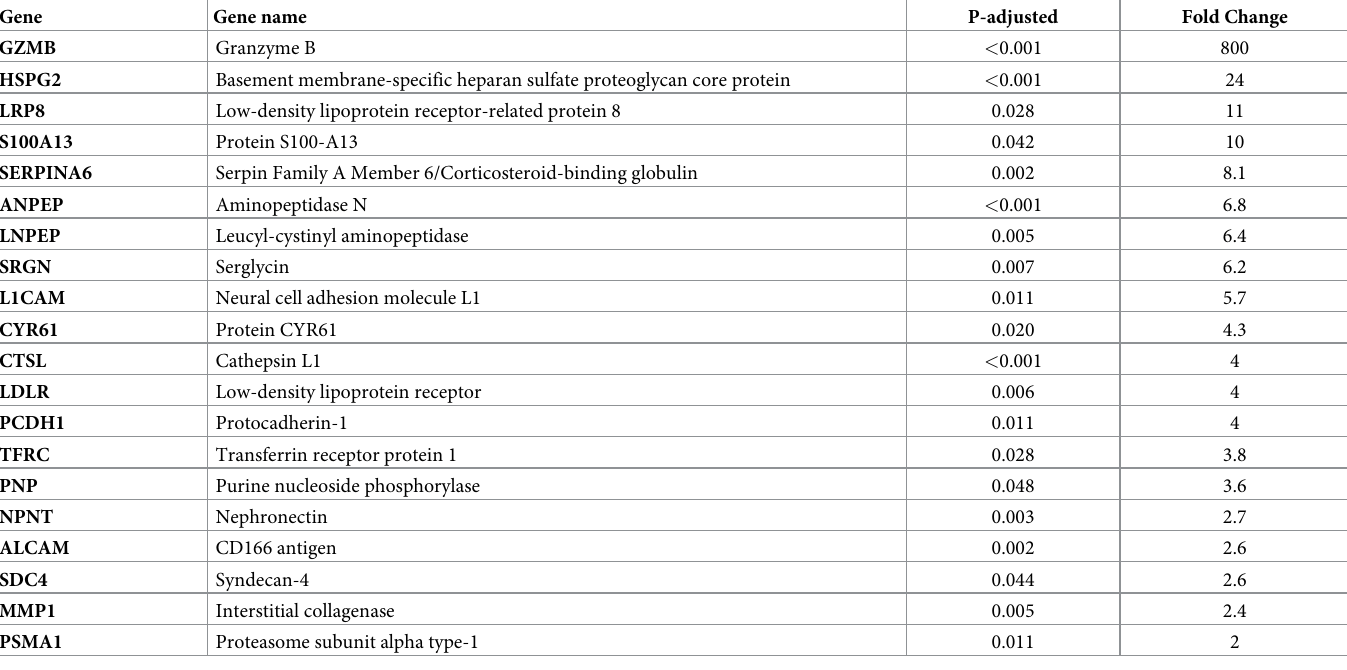
Table 1. Upregulated proteins in ARCaP-M conditioned media compared to